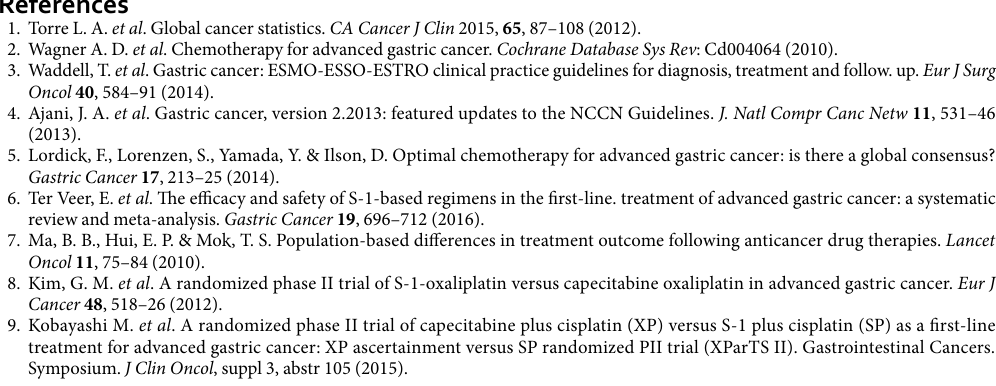
To evaluate differences in efficacy between fluoropyrimidines in Asian and Western patients, sub-group NMAs were conducted for studies in Asian and Western populations. Publication bias was assessed by funnel plots. All meta-analyses were performed using random-effects models and tested two-sided with α = 0.05.